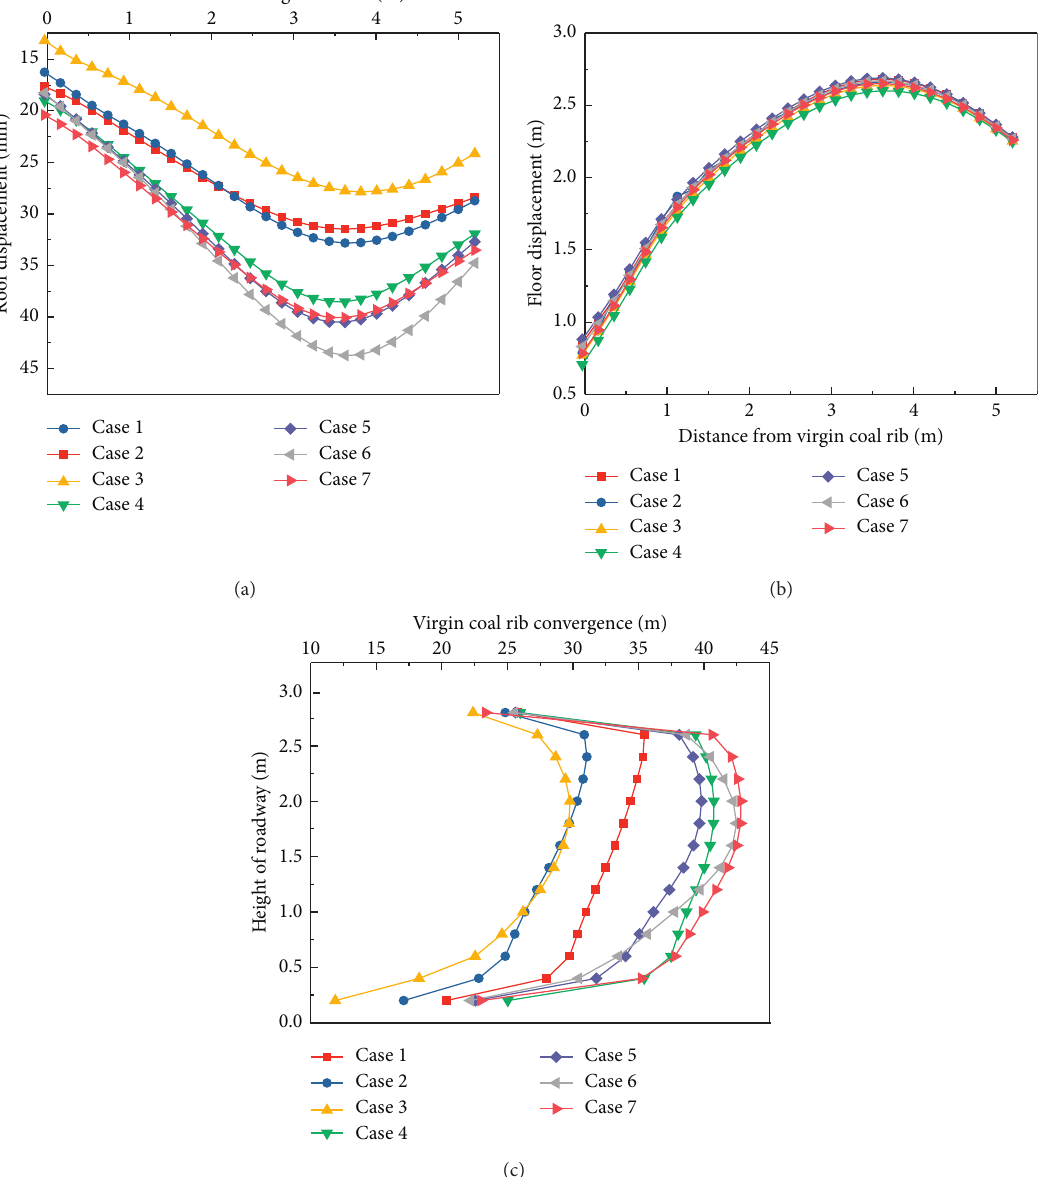
Figure 14: The deformation of the surrounding rocks under different fracturing cases. (a) Roof displacement. (b) Floor displacement. (c) Virgin coal rib